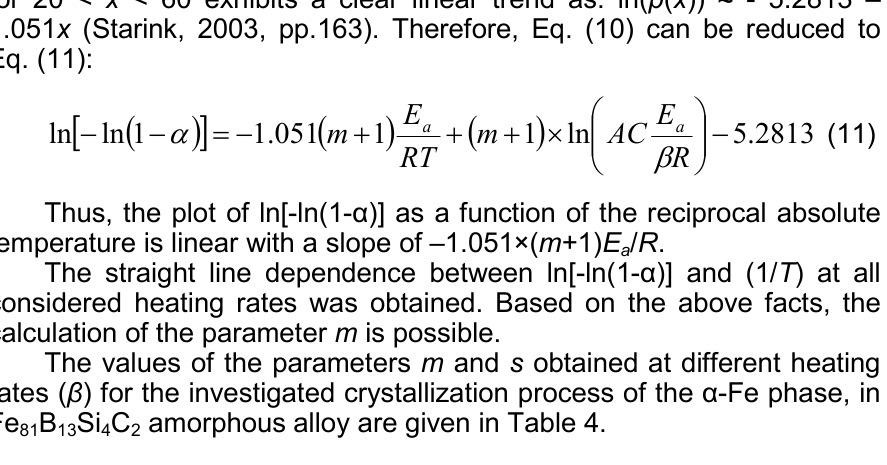
Table 4 – The dependence of the m and s parameter values on the heating rate β , for